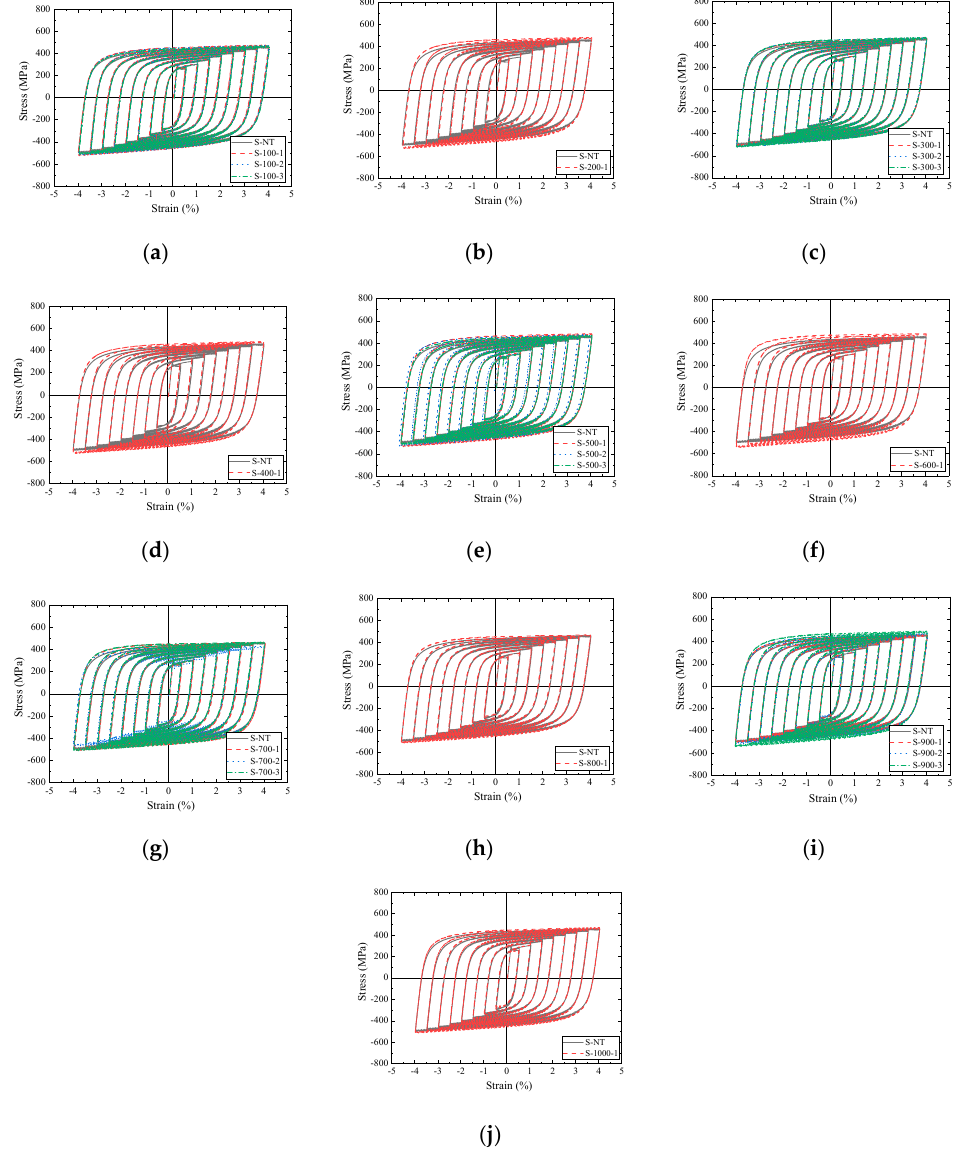
Figure 11. Hysteretic curves of Q235. ( a ) 100 °C; ( b ) 200 °C; ( c ) 300 °C; ( d ) 400 °C; ( e ) 500 °C; ( f ) 600 ◦ C;